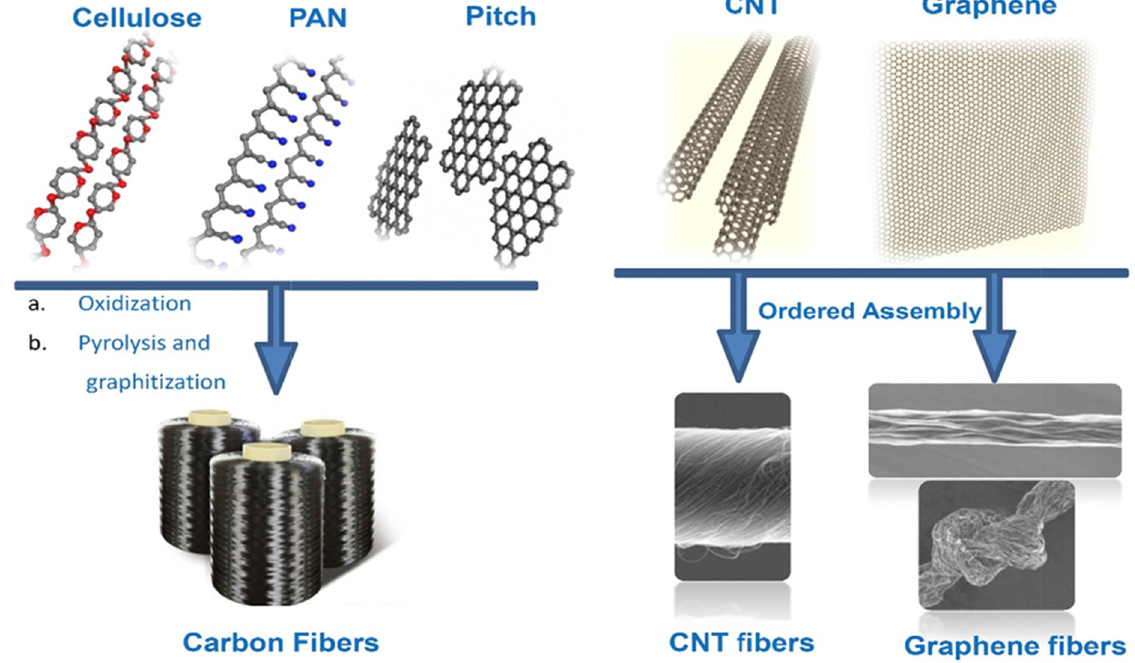
Figure 10. The precursor system of conventional carbon fibers, CNT, and graphene fibers